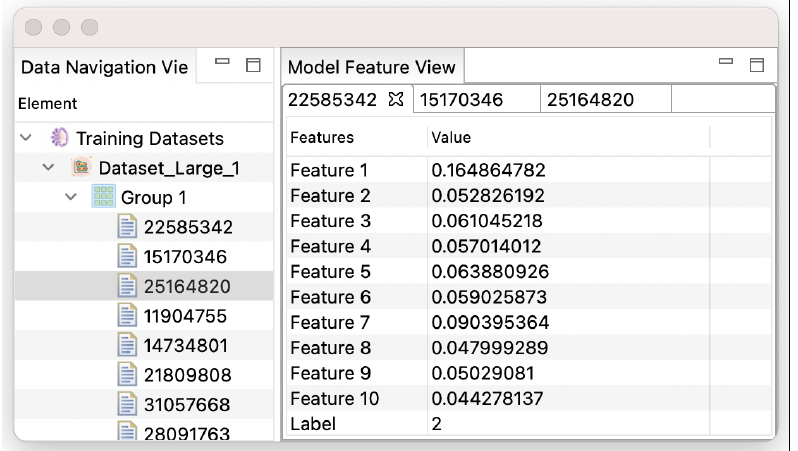
Figure 2. The tool screenshot of Data Navigation View and Model Feature View .